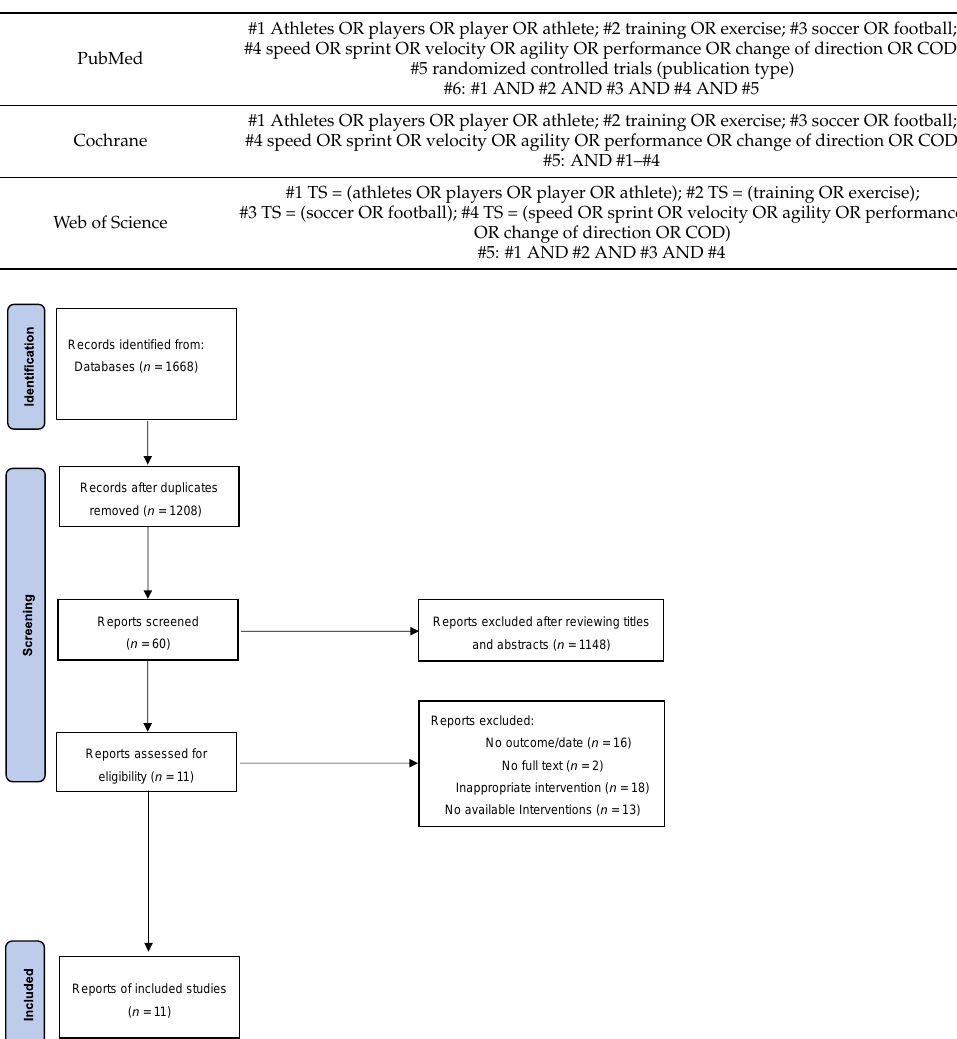
Table 1. Search strategy on PubMed, Cochrane, and Web of Science.